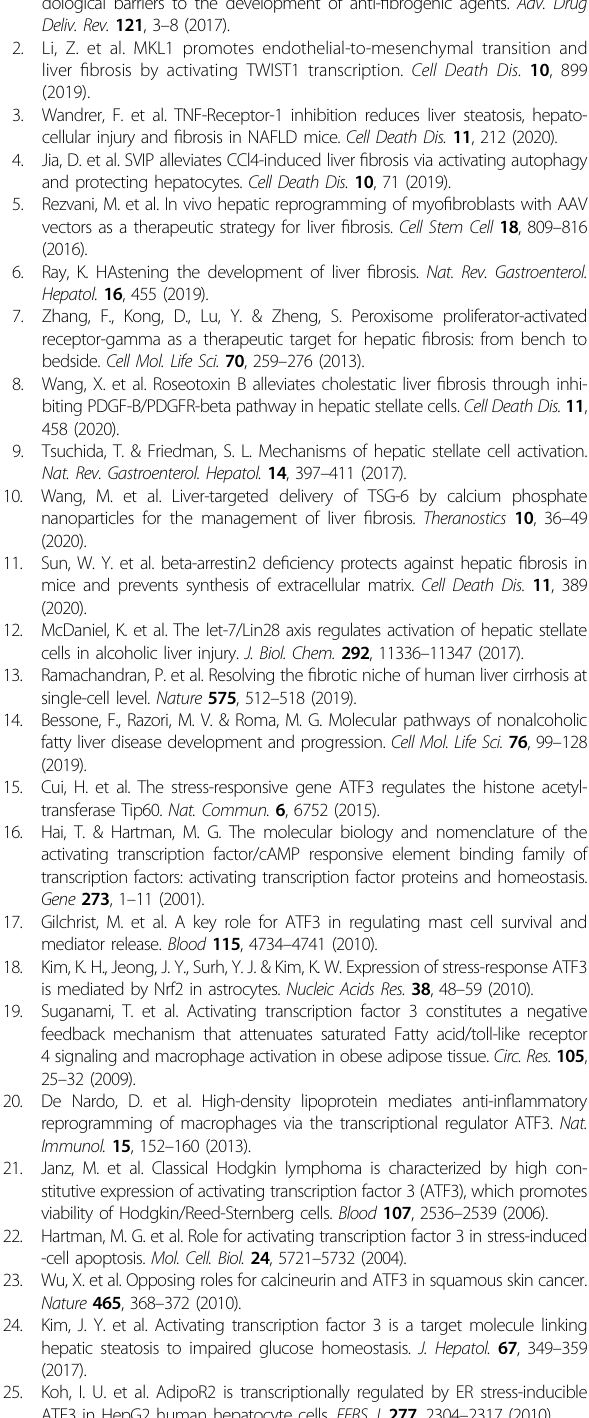
Table 4 Baseline characteristics of patients with liver